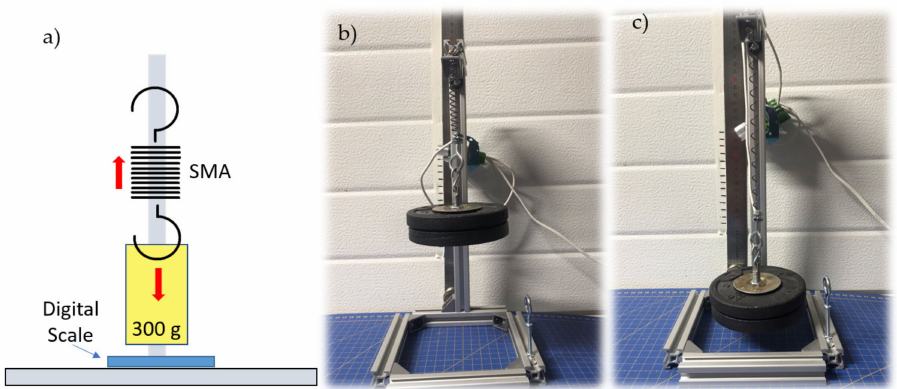
Figure 10. General setup for the experimental characterization of the SMA spring. ( a ) Scheme ( b , c ) Reality.